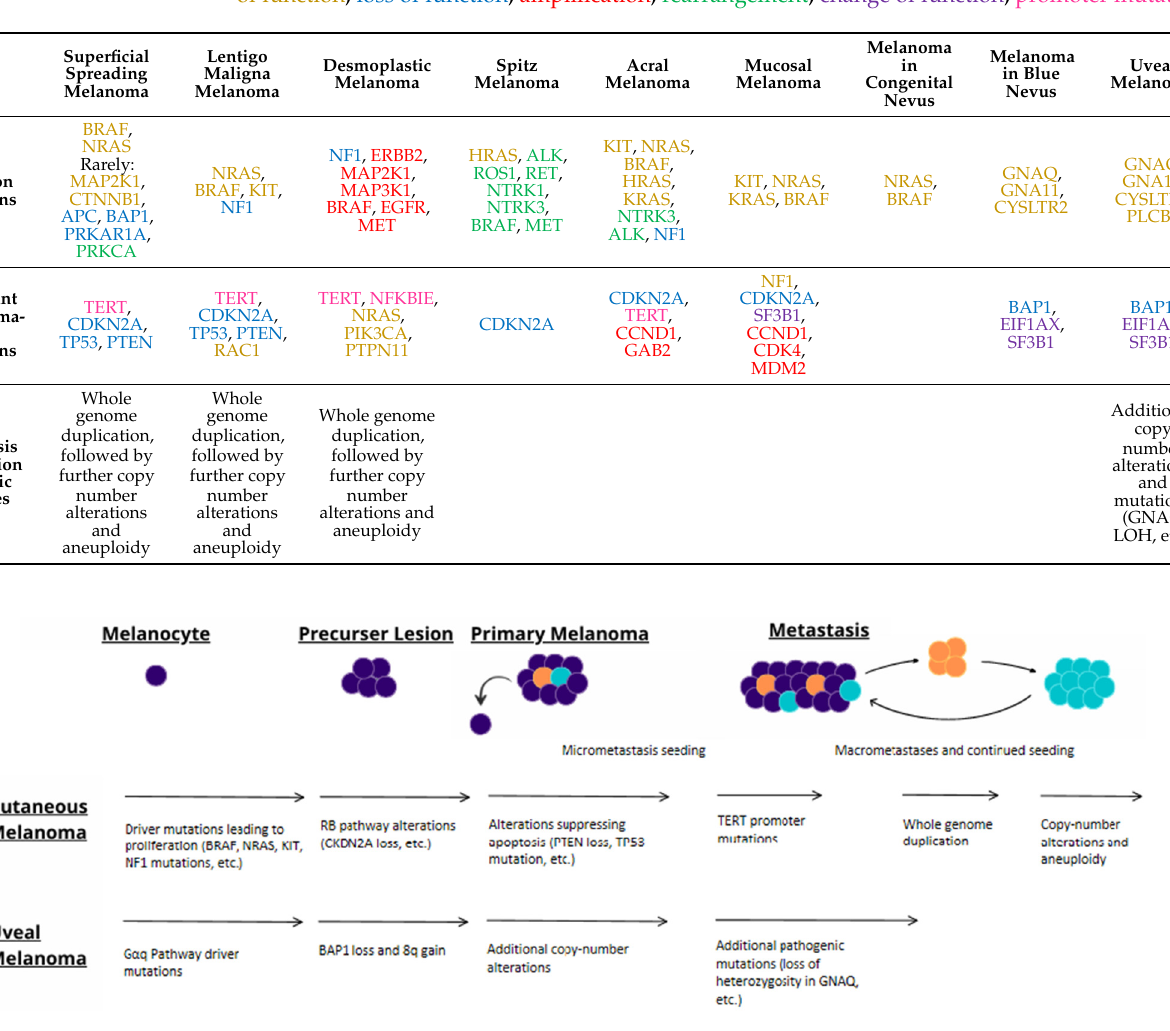
Table 1. Proposed genomic changes during the progression to melanoma, adapted from the World Health Organization Classification of Skin Tumours, 4th Edition. The color scheme is as follows: gain of function, loss of function, amplification, rearrangement, change of function, promoter mutation.